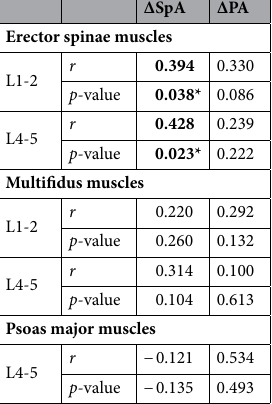
Table 2. Relationship between the fat infiltration rate in lumbar paravertebral muscles and the variations in dynamic spino-pelvic kinematic variables. SpA sagittal spinal angle, PA sagittal pelvic angle, r correlation coefficient. * p < 0.05. Significant correlation shown in